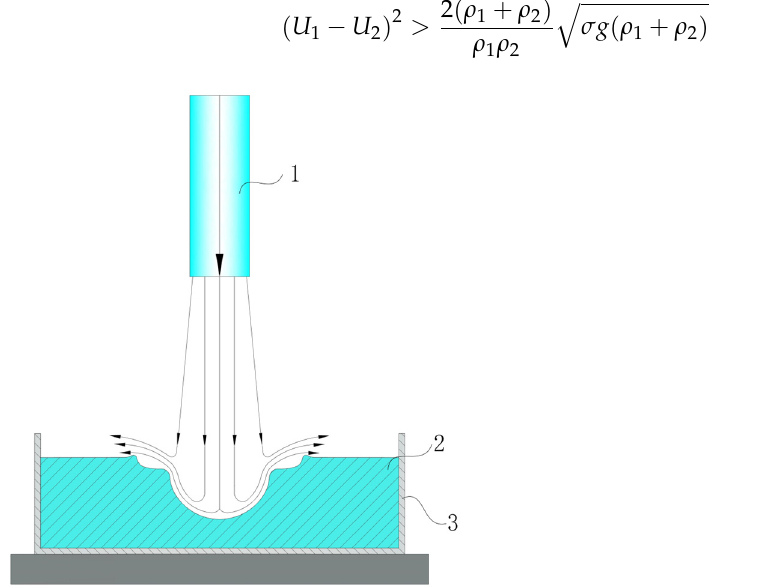
Figure 4. Schematic diagram of instability mechanism. (1) precision electroplated nozzle. (2) epoxy resin. (3) glass mould.